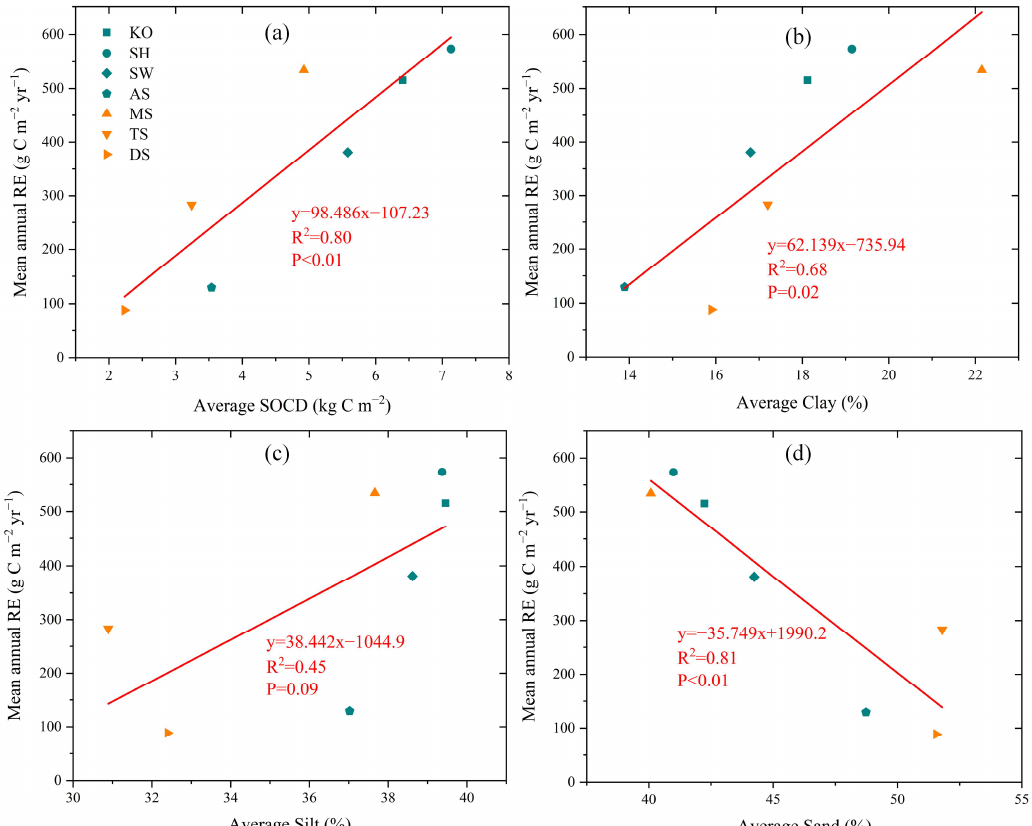
Figure 9. The correlation between the mean annual RE and ( a ) average SOCD, ( b ) average clay con- tent, ( c ) average silt content and ( d ) average sand content for all grids in each grassland subtype.